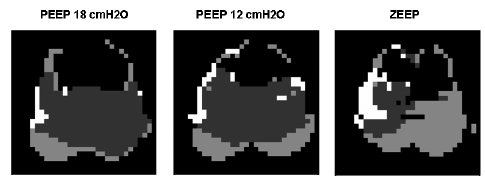
Figure 5 - Segmented lung map composed of three regions: dark gray - perfu- sion and ventilation match; light gray - predominantly perfused region; and white - predominantly ventilated region. The maps from left to right cor- respond to PEEP steps at 18 cm H O, 12 cm H O and ZEEP, respectively 2 2